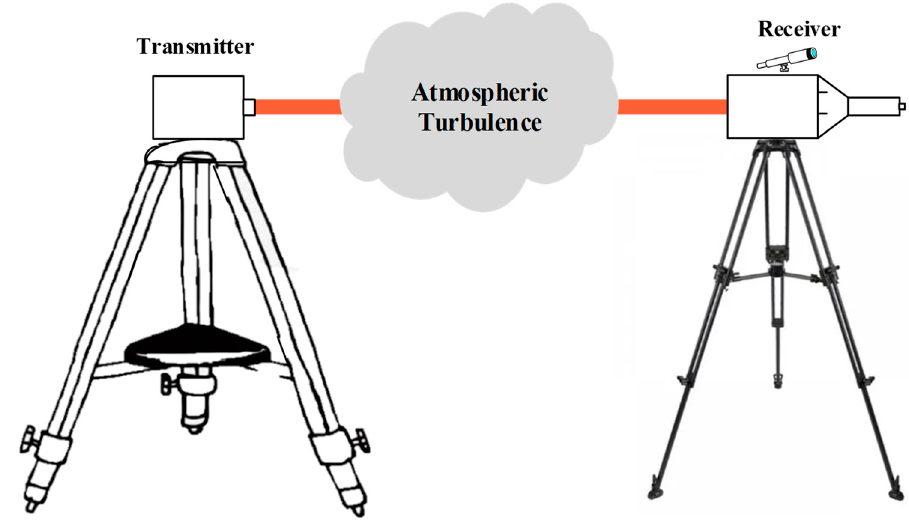
Figure 2. Schematic sketch of the traditional scintillometer.